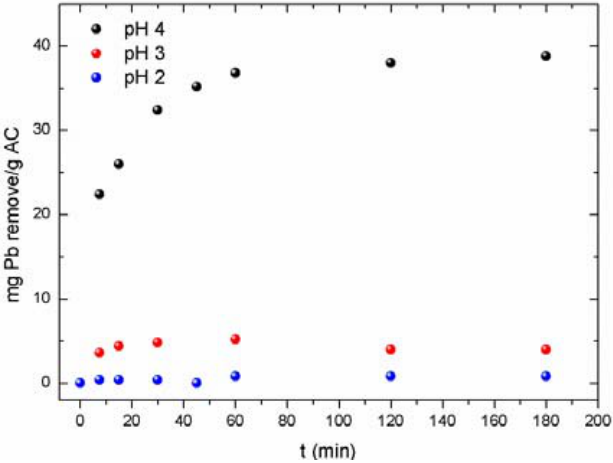
Figure 8. Influence of temperature on Pb 2+ removal from the aqueous solution. Stirring rate: 750 rpm.